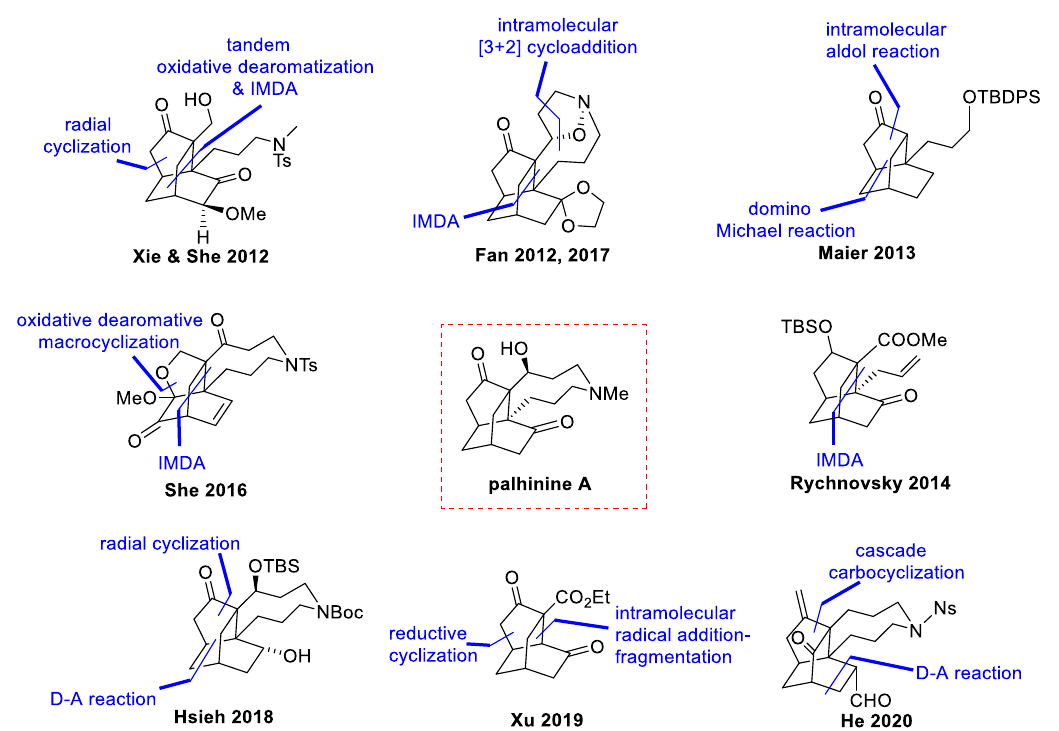
Figure 3. Overview of the reported key disconnections and intermediates towards the total synthesis of palhinine alkaloids.